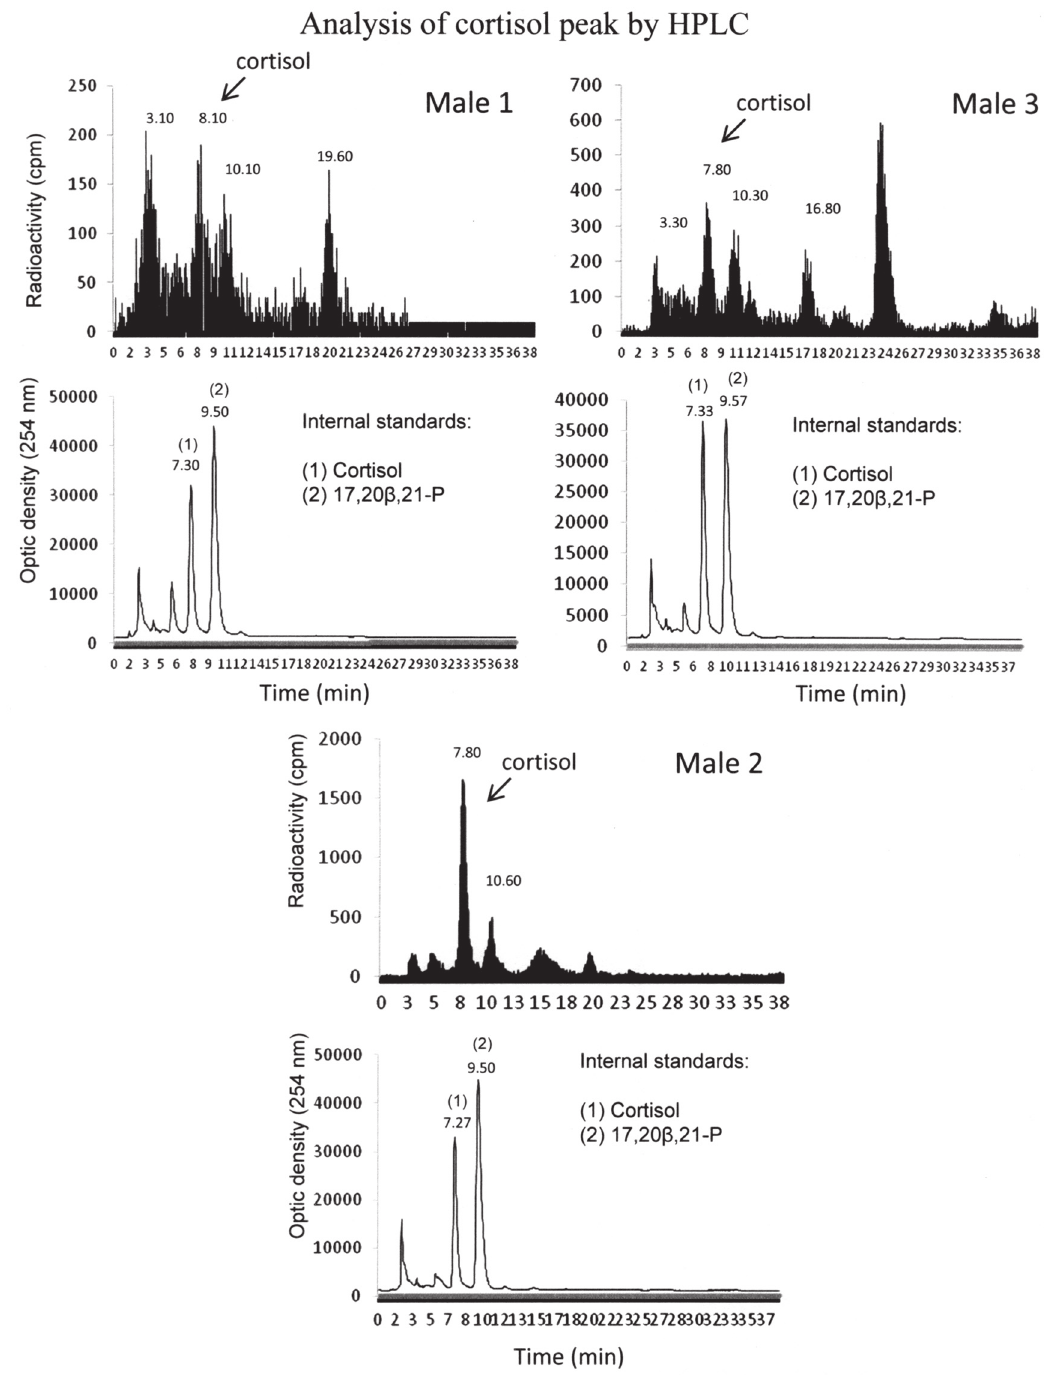
(system III) in Micropogonias furnieri